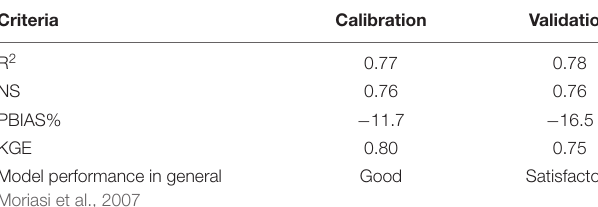
TABLE 6 | Model efficiency evaluation for daily runoff